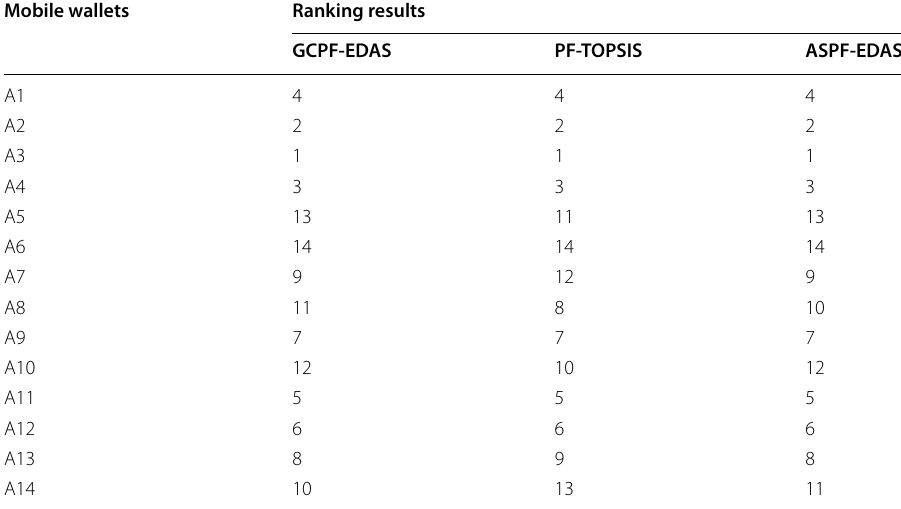
Table 13 Comparison of ranking Mobile wallets